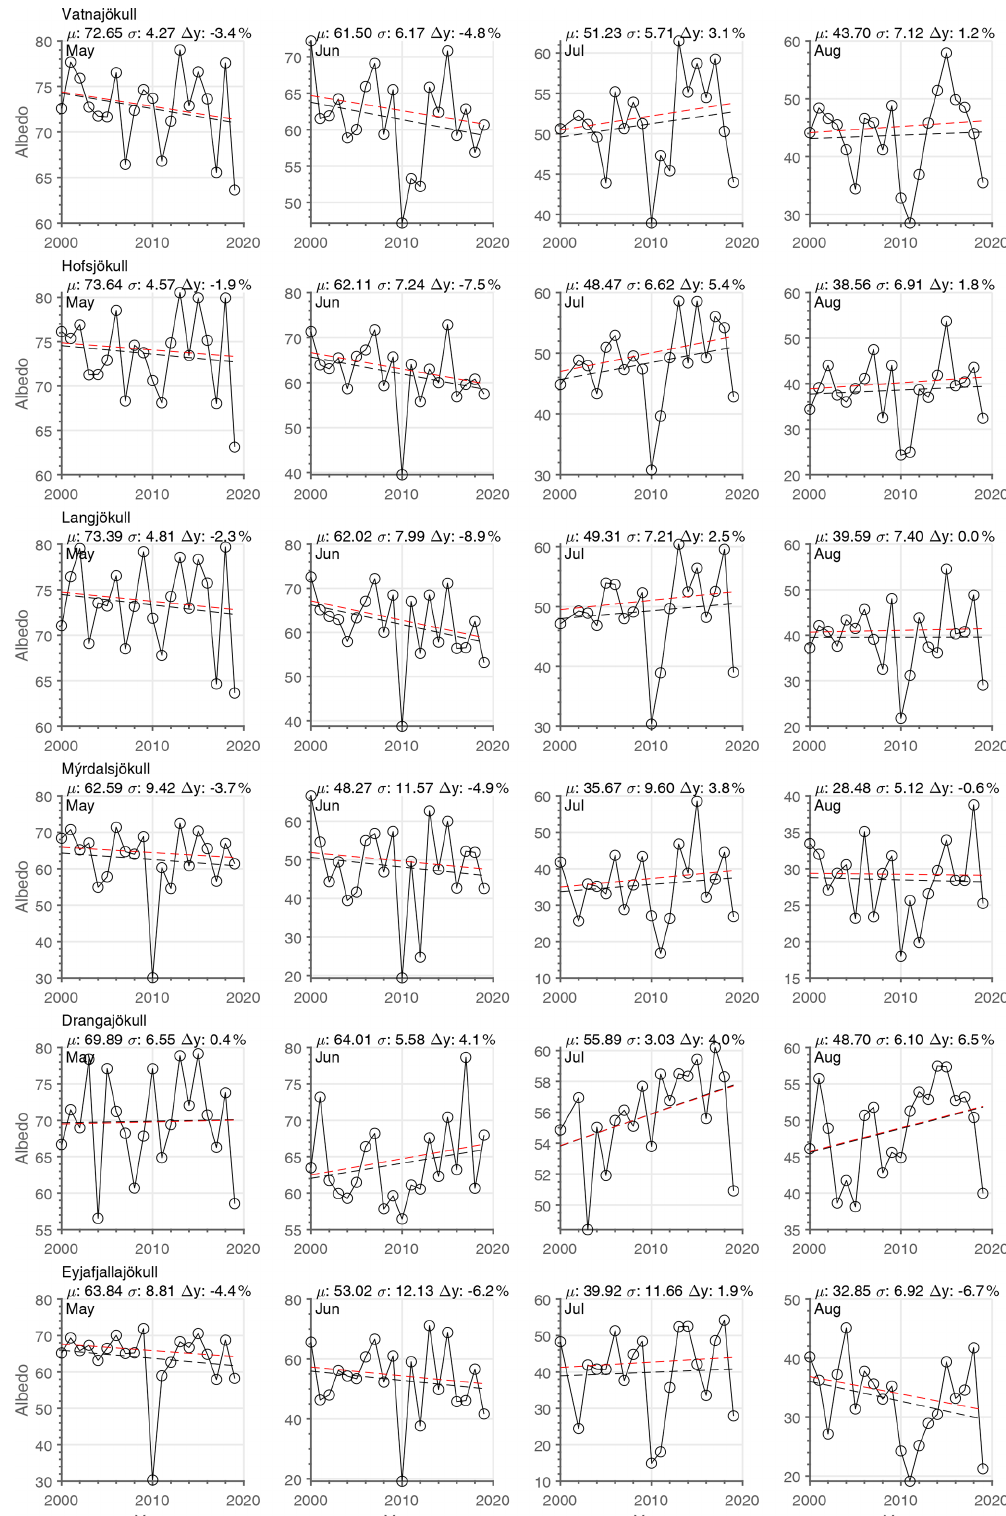
Figure 11. Average monthly mean albedo for the main ice caps in Fig. 8. The mean, standard deviation, and trend ( (cid:49)y ) are shown. Linear trend determined from all years is shown with black lines while red lines exclude the 2010 and 2011 data to omit the influence of volcanic tephra and